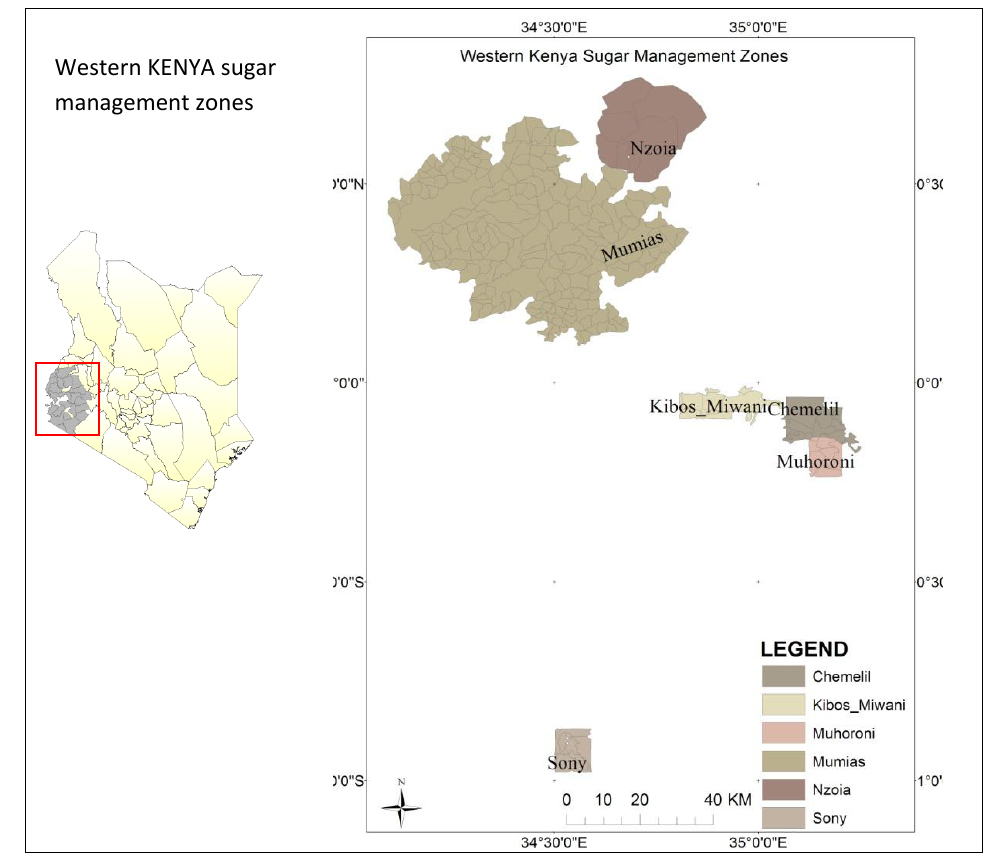
Figure 1. Western Kenya sugar management zones (Source: Sugar